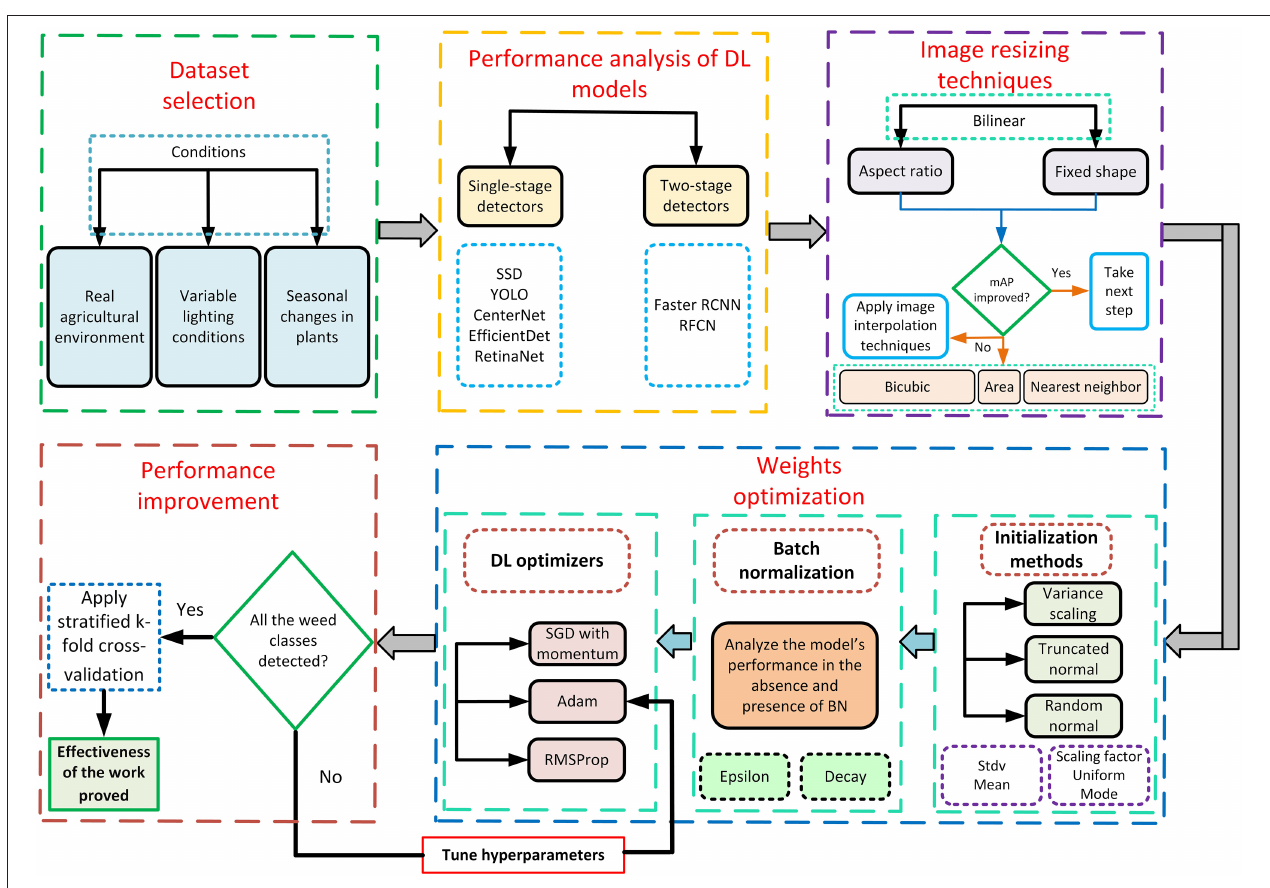
FIGURE 1 | Framework of this